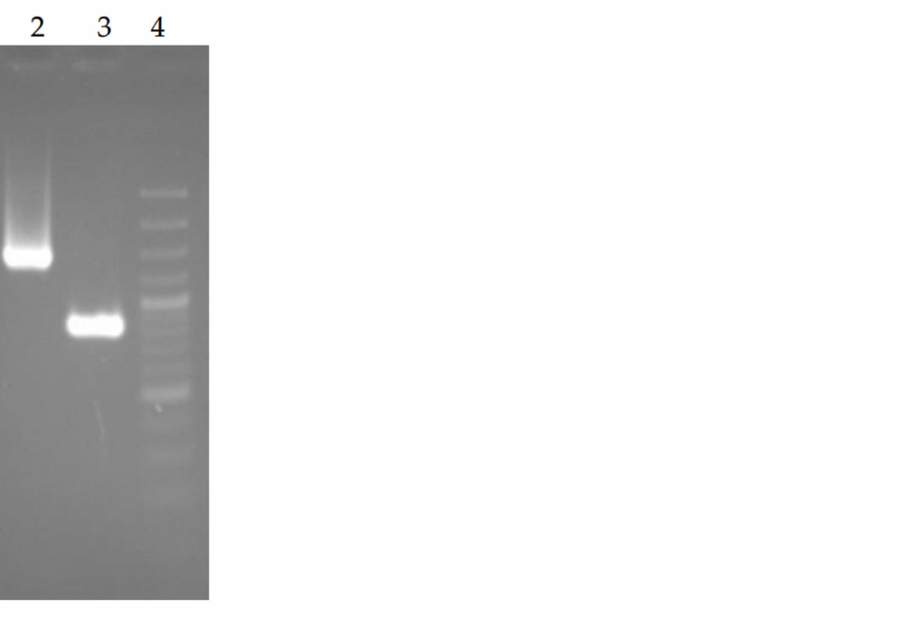
Figure 2. PCR analysis with FCD/RCD primers of F. tularensis DNA: 15 NIIEG—line 2, 15D—line 3. 100 bp plusDNA ladder (Fermentas)–lines 1 and 4.